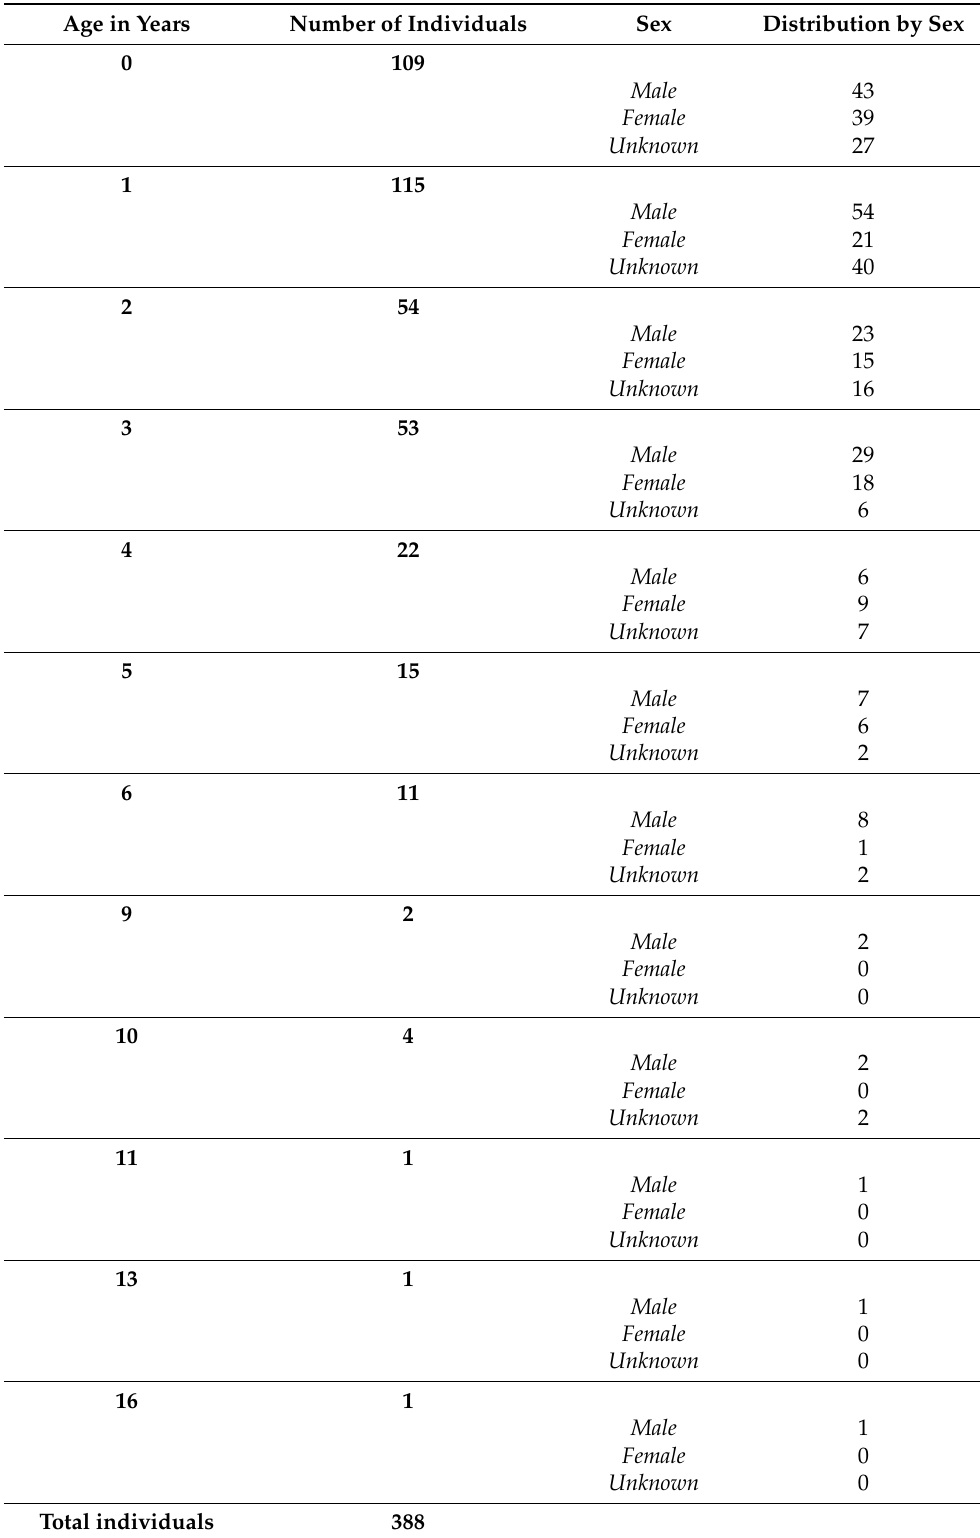
Table 2. Overview of age estimation data showing the number of individuals at each age, in years, out of a total sample of 388 hedgehogs. Age was estimated by counting the periosteal growth lines in transverse sections of the lower jaws. Rows are omitted where no individuals of that age were